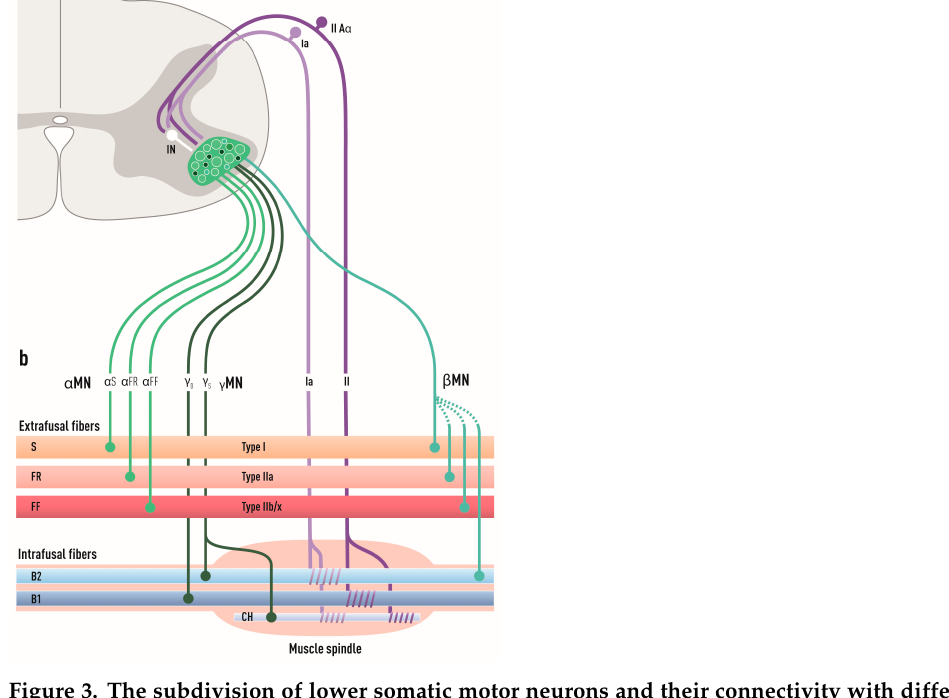
Figure 3. The subdivision of lower somatic motor neurons and their connectivity with different muscle fiber types. ( a ) Lower motor neurons located in the ventral horn of the spinal cord innervate skeletal muscle fibers. They receive modulating signals from interneurons and also integrate inhibitory signals from afferent sensory neurons (Ia and II group IIA α ) through the skeletal muscle that they both innervate. Although motor neuron somas are segregated according to muscle group in the motor column, the different motor neuron subtypes (alpha, beta, gamma) are intermingled. ( b ) Alpha motor neurons innervate extrafusal skeletal muscle fibers, which generate contractile forces. Alpha motor neurons are subdivided into fast-twitch fast fatigable (FF), fast-twitch fatigue-resistant (FR), and slow-twitch (S), which innervate type IIb/x, type IIa, and type I muscle fibers, respectively. Gamma motor neurons that are coactivated together with alpha motor neurons innervate intrafusal fibers that form stretch receptors in the form of muscle spindles and create a parallel pull of extra- and intrafusal fibers. The stretching of the spindle is detected by sensory neurons wrapping around the intrafusal fibers. Gamma motor neurons form two subtypes (dynamic and static) innervating intrafusal nuclear bag fibers (B1, B2) and nuclear chain fibers (CH). The dynamic units are required for quick adjustments to muscle tonus, whereas the static units are mainly involved in maintaining muscle tonus while posturing. Beta motor neurons innervate the muscle spindles and also have collaterals to the extrafusal fibers.